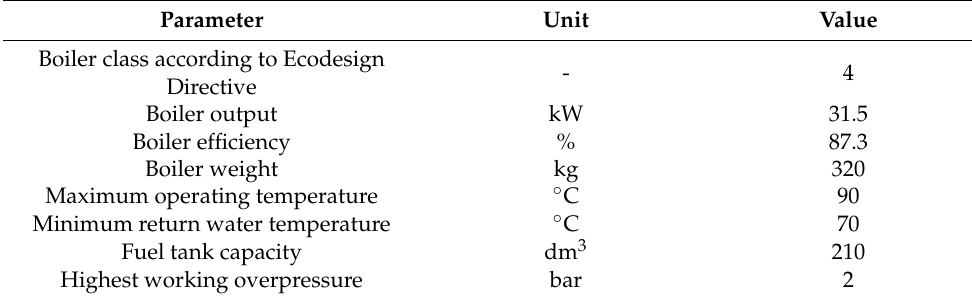
Table 1. Specifications of the VARIANT SL33A pellet boiler.